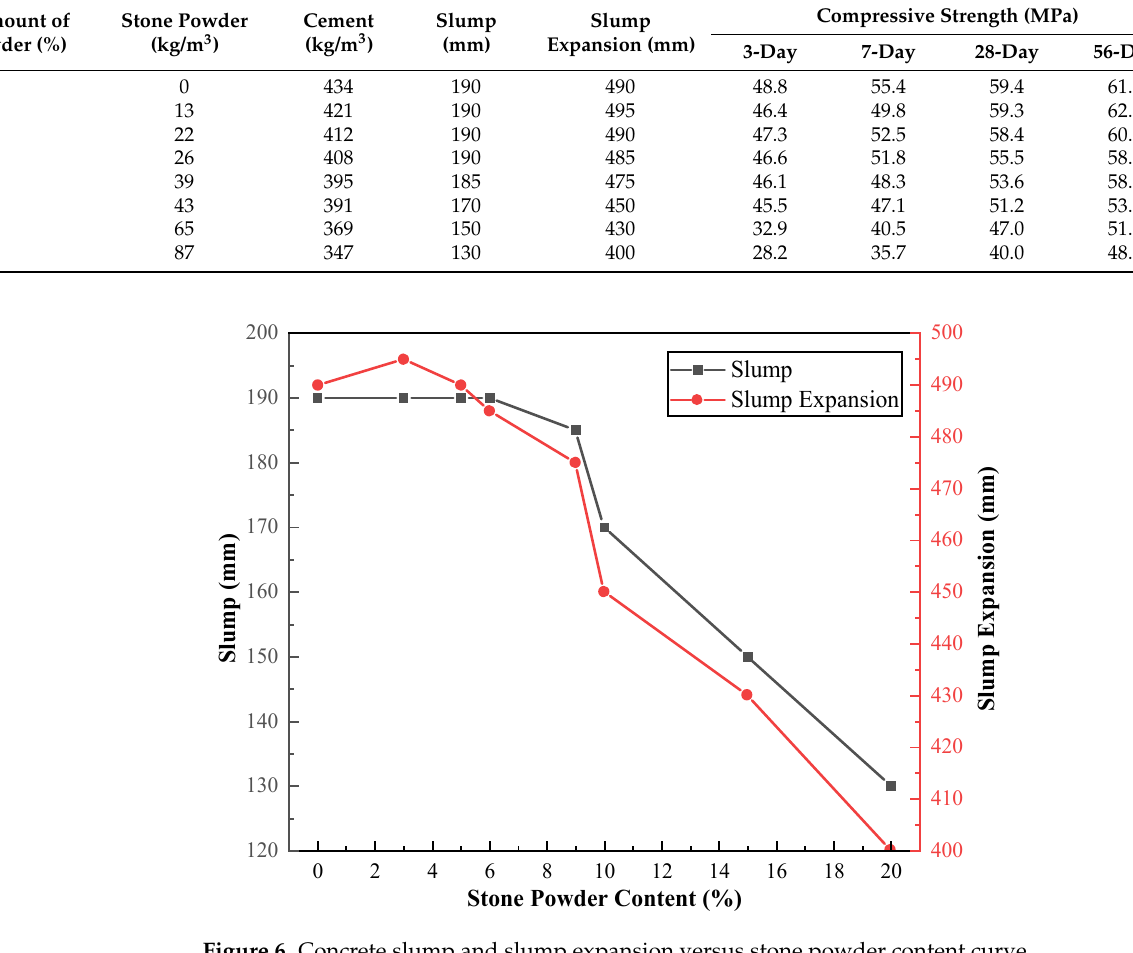
Figure 7. Concrete compressive strength versus stone powder content curve. As can be seen from Figure 7, the compressive strength of concrete at different ages gradually decreases when the percentage of stone powder replacing cement increases from 0% to 20%. The amount of change in compressive strength of stone powder content within 10% was less than 10% to 20%, and the 3-day compressive strength decreased by 6.8% and 38.0%, respectively. When the stone powder content was within 5%, the com- pressive strength of concrete at 28-day and 56-day changed less and maintained a high level. The compressive strength of concrete at 7-day decreases and then increases, reach- ing a peak at 5% of stone powder content. It indicates that the effect of stone powder con- tent on the compressive strength of the concrete of machine-made sand at different ages is basically the same. The effect of stone powder on the compressive strength of machine- made sand concrete has both advantages and disadvantages. The benefit is that the filling effect of stone powder improves the interfacial transition zone between aggregate and